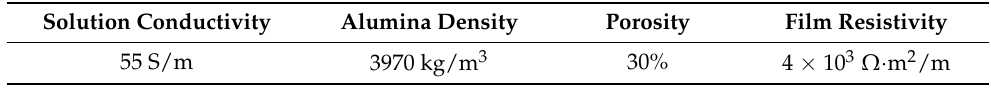
Table 1. Other parameters of simulation model.